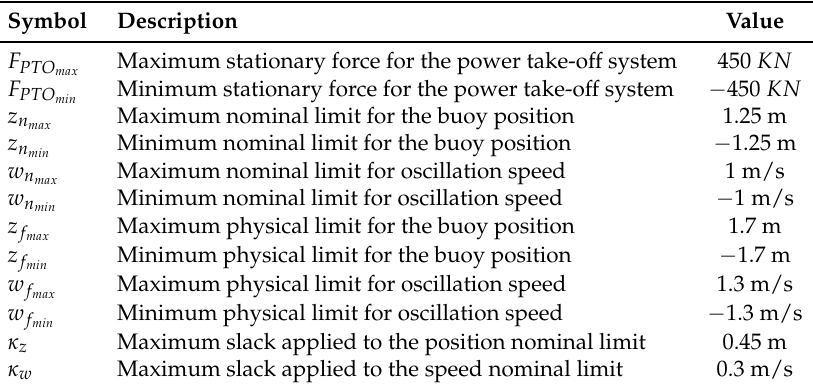
Table 3. Hard and soft constraints for the WEC